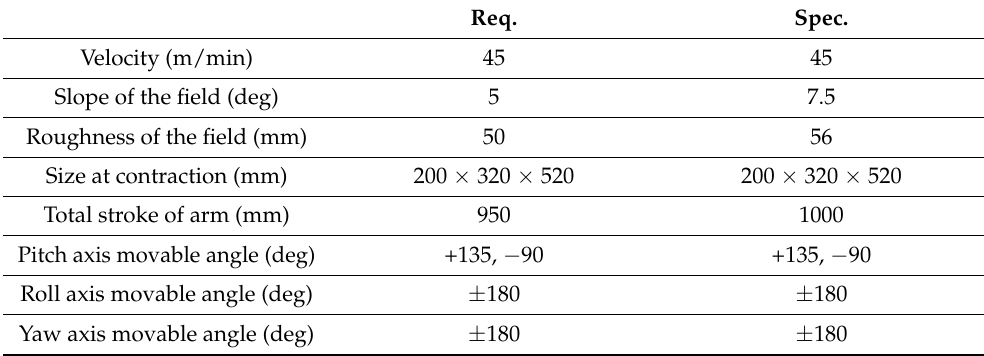
Table 1. Requirements and